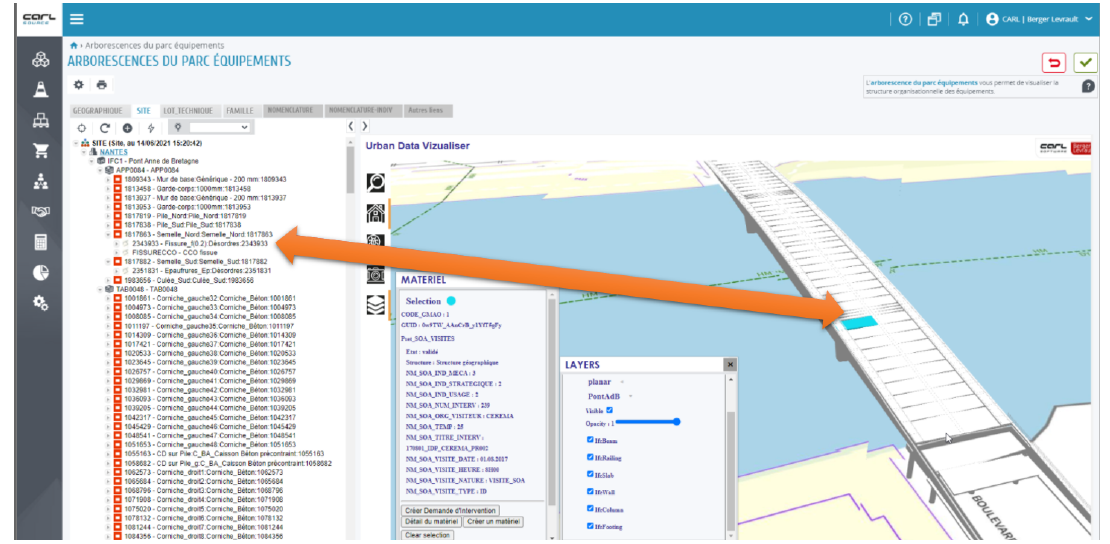
Figure 7. Possible navigation between a spatial representation of a slab in a bridge, from an Ifc file (in blue), and its thematic representation in a CMMS software